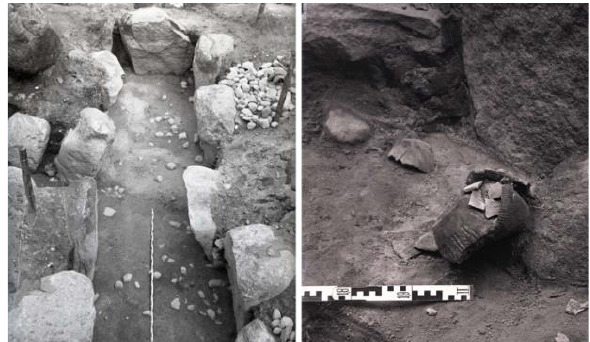
Figure 8: Burial chamber 1, view of support stone 3 and the threshold stone of the entrance (left); sherds of a total of three vessels pressed into each other in Burial chamber